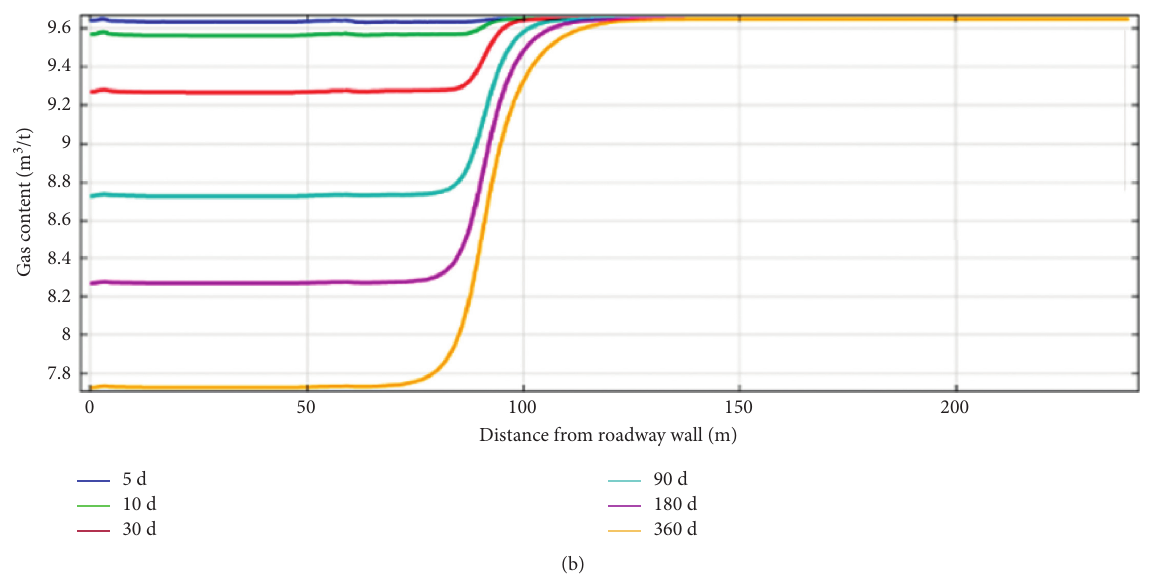
Figure 12: Distribution of gas content in 90m borehole with different drainage time: (a) gas content distribution on the monitoring line in the strike direction; (b) distribution of gas content in the trend direction monitoring line.